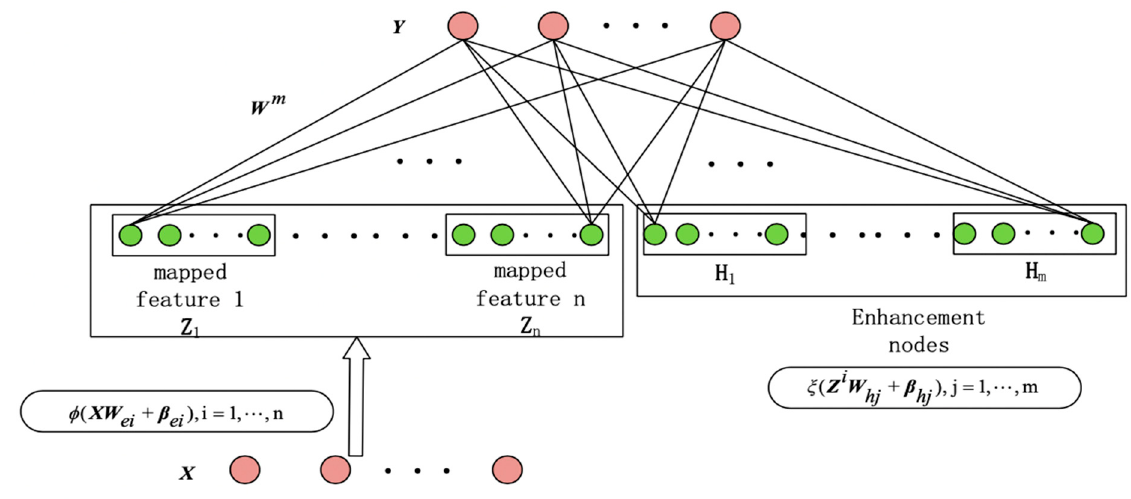
Figure 3. BLS network.